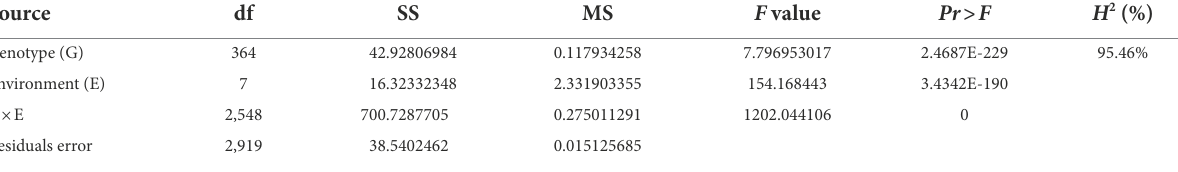
TABLE 2 Analysis of variance of Fusarium ear rot resistance.